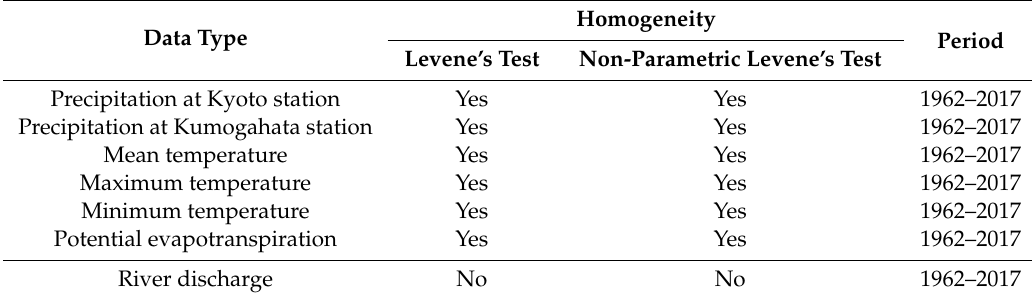
Table 1. Results of homogeneity test on hydroclimatic data at the annual